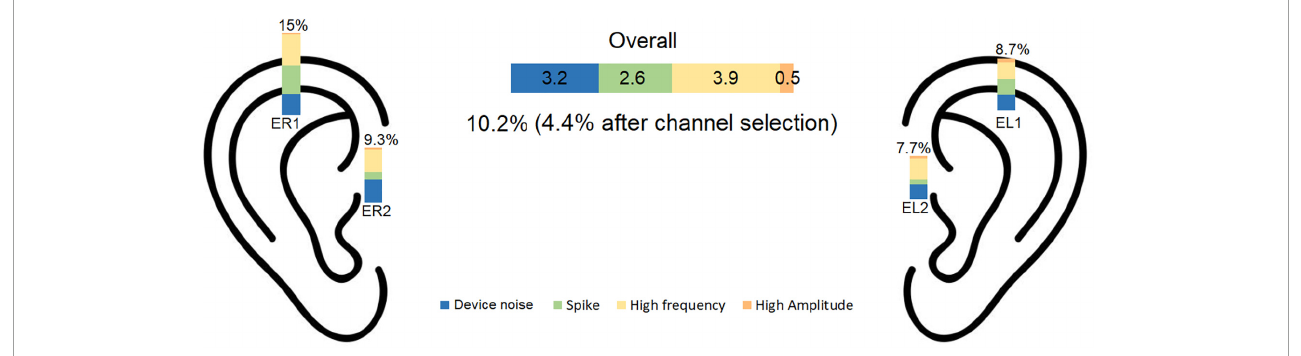
FIGURE4 Percentage of rejected data is illustrated for each noise category for each electrode. The overall rejection percentage was 10.2% before and 4.4% after channel selection. EL1, left electrode 1; EL2, left electrode 2; ER1, right electrode 1; ER2, right electrode 2.